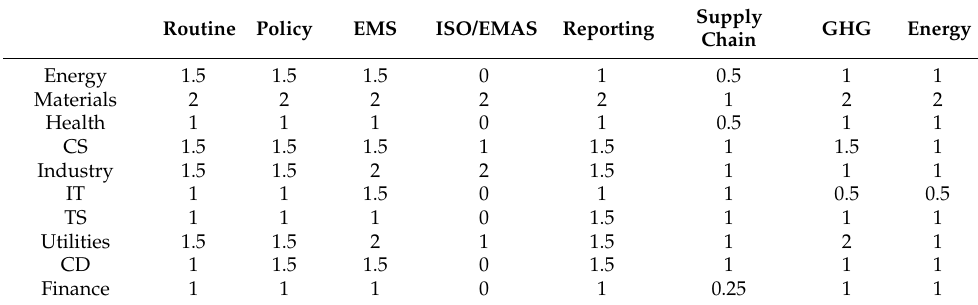
Table 8. Partial grades’ medians among